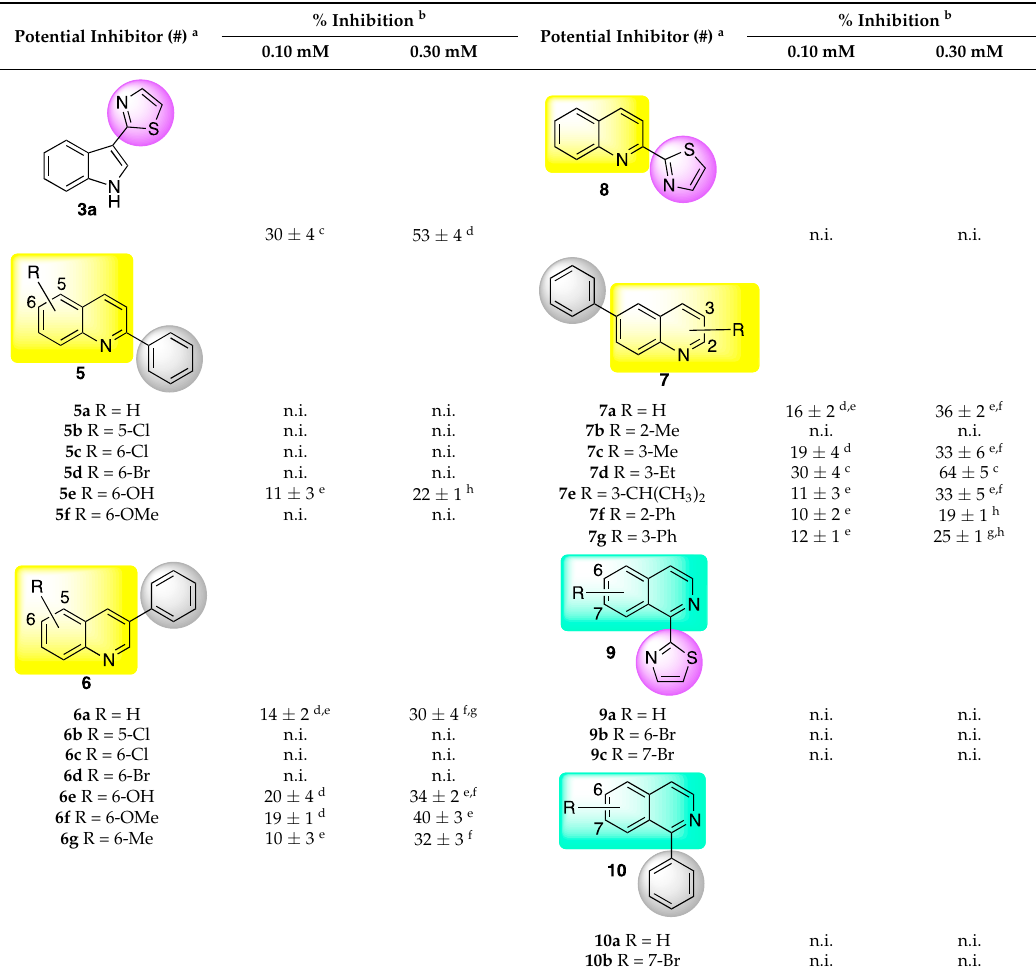
Table 3. Inhibitory effect of camalexin ( 3a ) and quinolines 5a – 8 and isoquinolines 9a – 10b on BOLm activity.